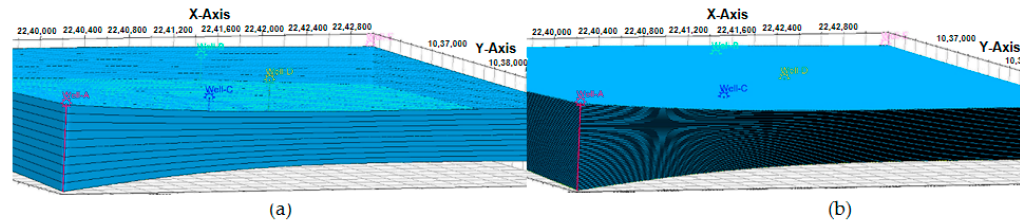
Figure 7. Structural grid of the studied reservoir; ( a ) Low-resolution grid cells (71,760 cells), ( b ) High-resolution grid cells (72,649,401 cells).